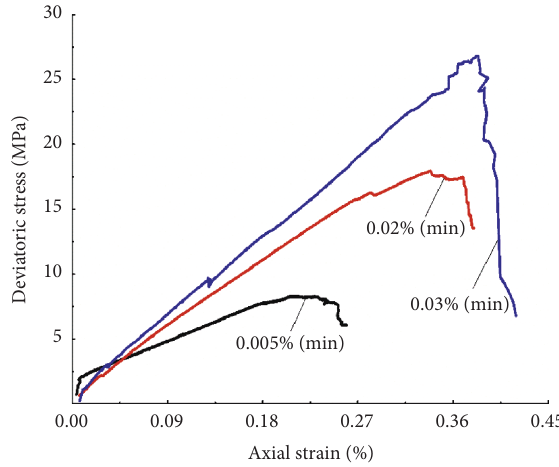
Figure 4: Stress and strain process